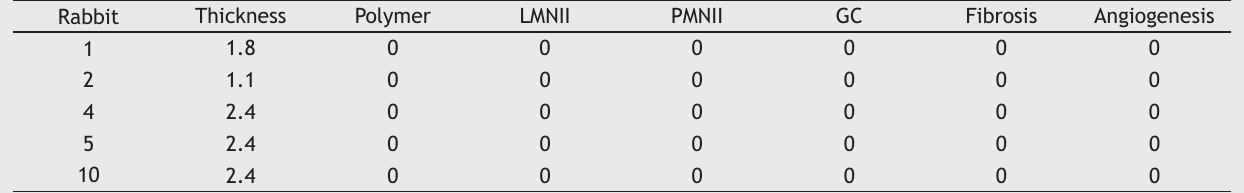
Table 2 Histological characteristics found in Group I - 21 days – Control vocal fold. Rabbit